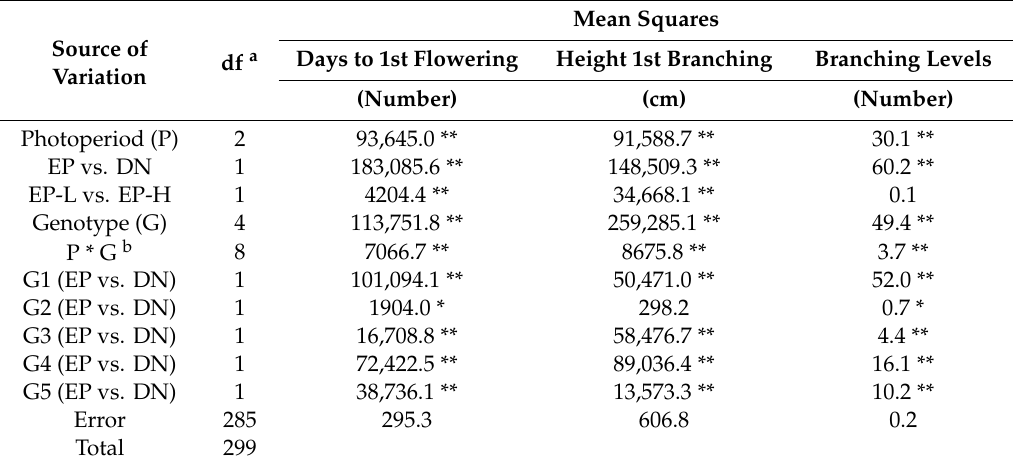
Table 2. Analysis of variance for data from Experiment 1 (2016 / 17 season). Useful orthogonal contrasts were used to partition the sources of variation due to photoperiod and photoperiod * genotype